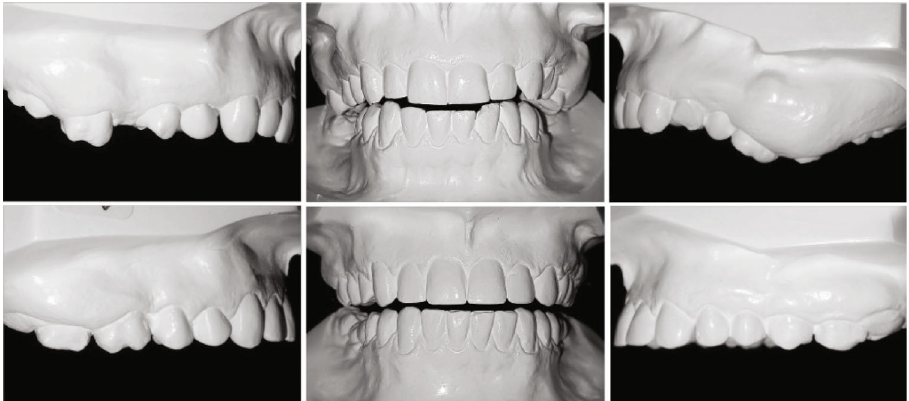
Figure 10: Pretreatment and posttreatment dental casts. Uneven occlusal